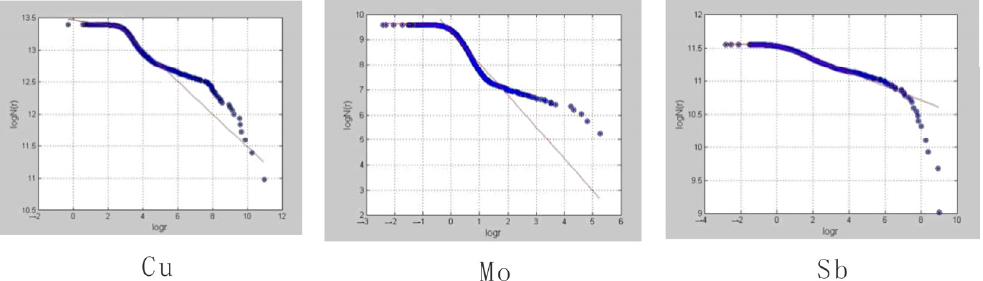
Figure 2. Fractal chart of Cu, Mo, and Sb (unit: ppm).